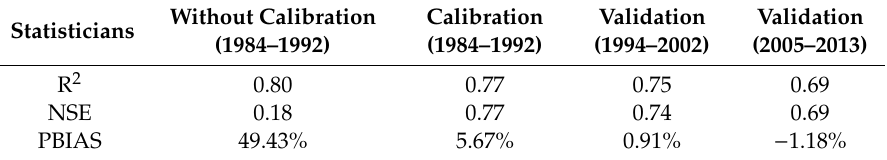
Figure 4. Relationship between uncalibrated and calibrated values against observed values ( a ) and validated values against observed values ( b ) for a model with proportional bias (y = z). Calibration and validation of the total monthly flow of LU_1986, LU_2001, and LU_2011 for the time periods of 1984–1992 ( c ), 1994–2002 ( d ), and 2005–2013 ( e ). Table 5. Correlation between calibration and validation periods for “Rio Andalien Camino a Penco” station.